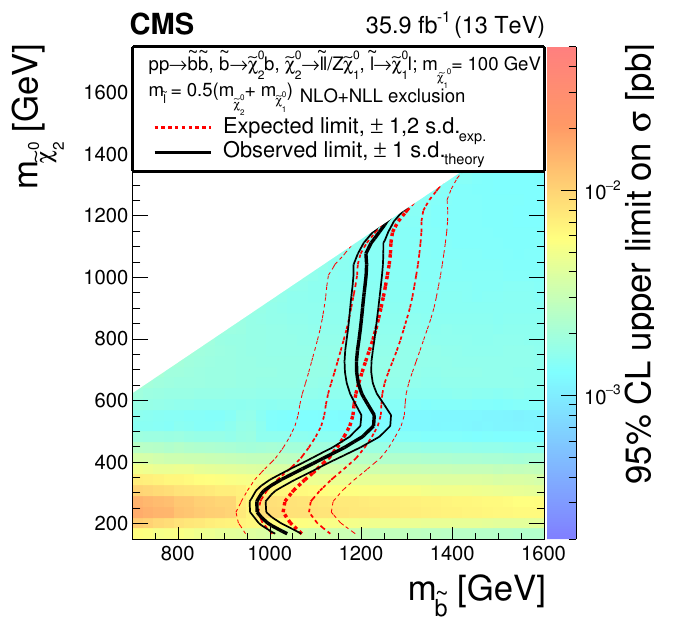
Figure 10 . Cross section upper limit and exclusion contours at 95% CL for the slepton edge model as a function of the b and (cid:31) 0 masses, obtained from the results of the edge search. The region 2 to the left of the thick red dotted (black solid) line is excluded by the expected (observed) limit. e The thin red dotted curves indicate the regions containing 68 and 95% of the distribution of limits e expected under the background-only hypothesis. The thin solid black curves show the change in the observed limit due to variation of the signal cross sections within their theoretical